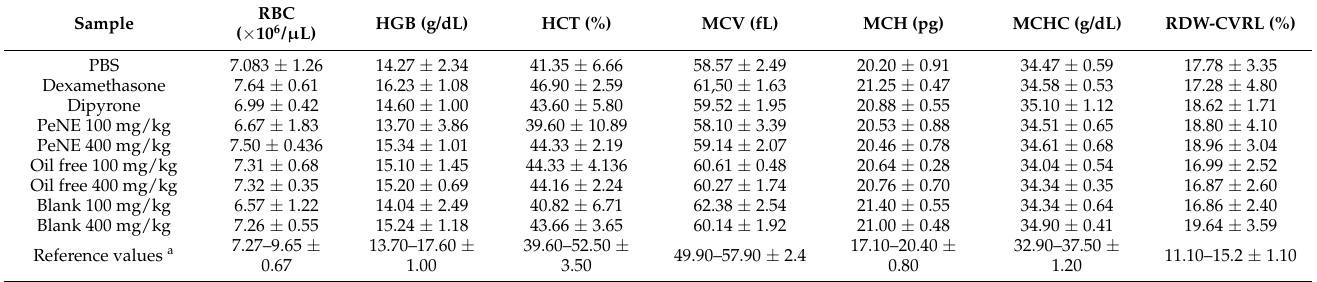
Table 4. Erythrogram analyses in male Wistar rats after oral treatment with PeNE or free pequi oil for 15